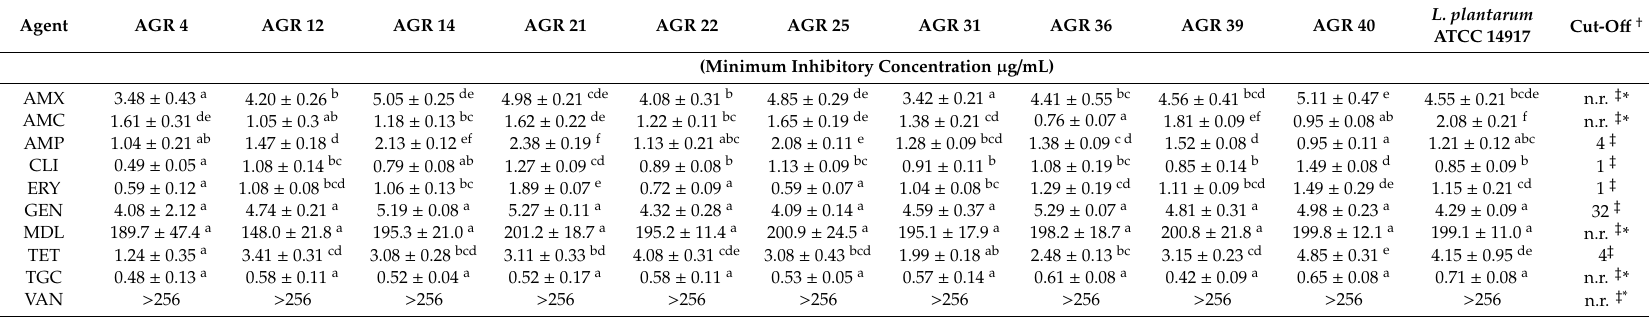
Di ff erent superscript letters in a row indicate statistically significant di ff erences among the strains (ANOVA, Tukey’s HSD, p < 0.05). † Breakpoints are referred to L. casei / paracasei strains. ‡ According to EFSA, strains with a minimum inhibitory concentration (MIC) higher than the breakpoints are considered resistant (EFSA, 2012). * not